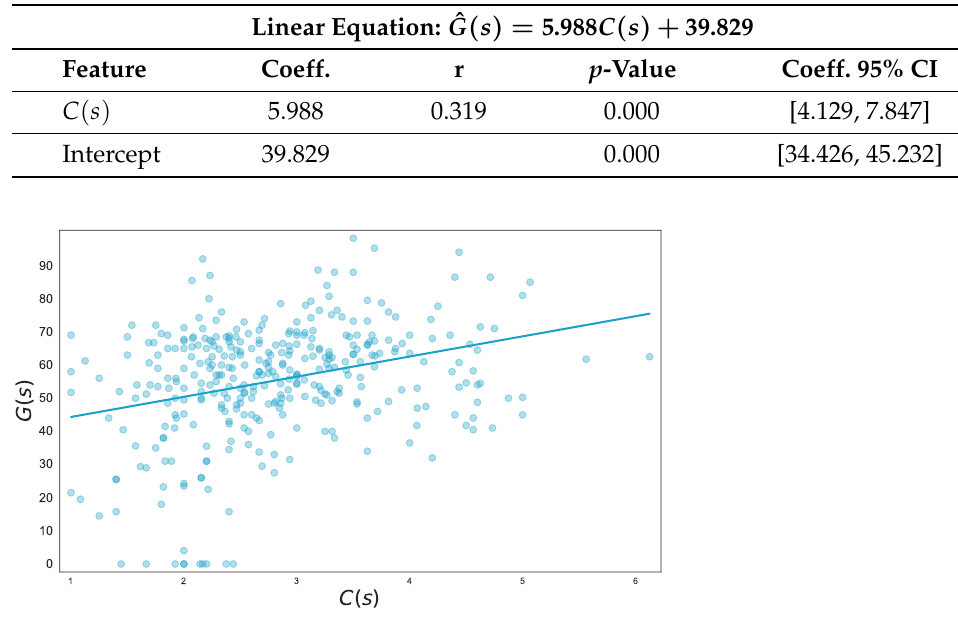
Figure 4. Average Number of Weekly Active Days against Grade. r = 0.319, p =